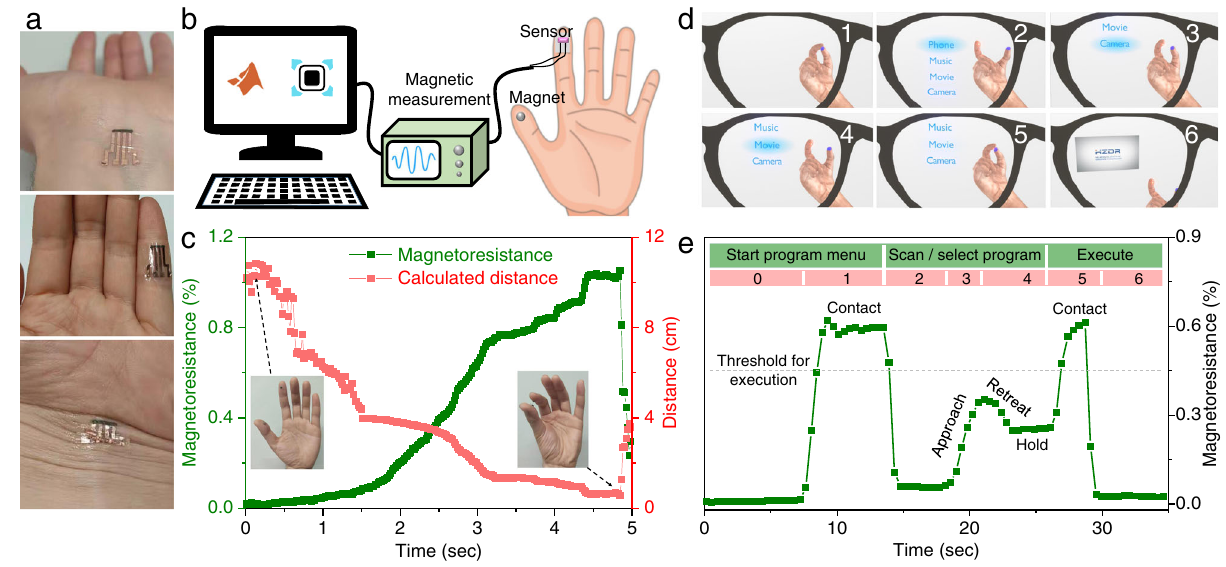
Fig. 5 | On-skin printable magnetoresistive sensors for medical therapy and augmentedreality.a Photographsofsensorsprinted on100- μ m-thickplasticfoil, conformably attached onto skin (from top to bottom) with planar, bent and crumpledsurfaces. b , c Fingertrainingapplicationinmedicaltherapy. b Schematic illustration of experimental con fi guration (from right to left): sensor and magnet compliantly adhering onto thumb and fore fi nger, magnetoresistance measure- ment,and analysis. c Magnetoresistancevariationastwo fi ngers wereapproaching and two- fi nger distance calculated from magnetoresistance readout. Inset: